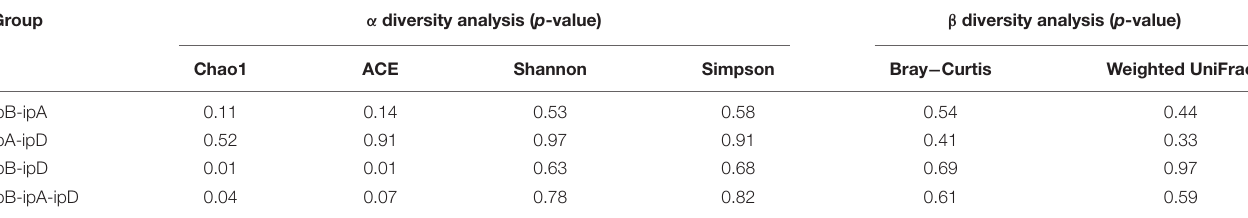
TABLE 3 | Alpha and beta diversity statistical